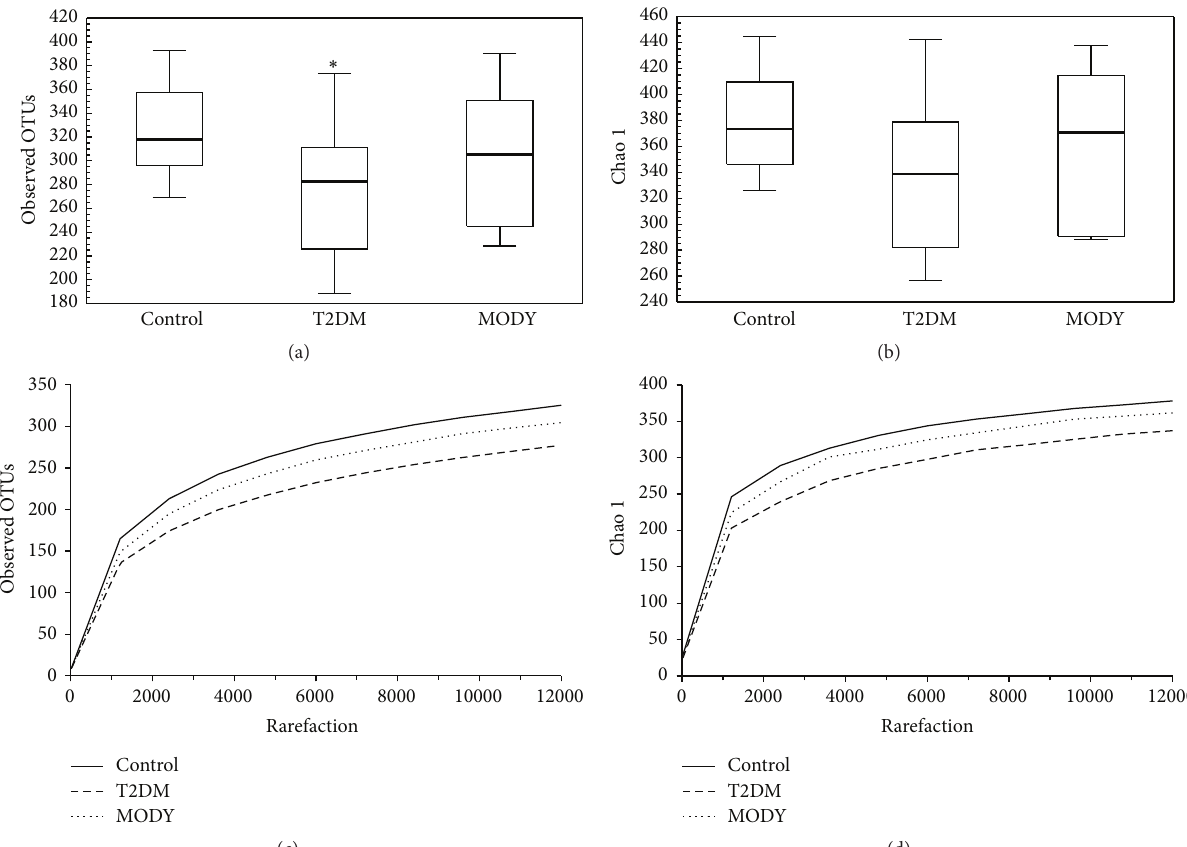
Figure 4: Box plots showing the alpha diversity ((a) observed OTUs, (b) Chao 1) comparison between groups. The rarefaction plots comparison ((c) observed OTUs, (d) Chao 1). Bold line: median; black lines: range of values. The observed OTUs but not Chao 1 alpha diversity were lower in T2DM group than in the control group. There were no significant differences in alpha diversity between T2DM and MODYandMODYandcontrolgroups.(a)ObservedOTUalphadiversity:controlversusMODY, 𝑝 = 0.846 ;controlversusT2DM, 𝑝 = 0.027 ; MODY versus T2DM, 𝑝 = 0.726 . (b) Chao 1 alpha diversity: control versus MODY, 𝑝 = 1 ; control versus T2DM, 𝑝 = 0.063 ; MODY versus T2DM, 𝑝 = 0.816 . OTU: operational taxonomic unit; T2DM: type 2 diabetes mellitus; MODY: Maturity Onset Diabetes of the Young. ∗ indicates that there was a significant difference between this group and control